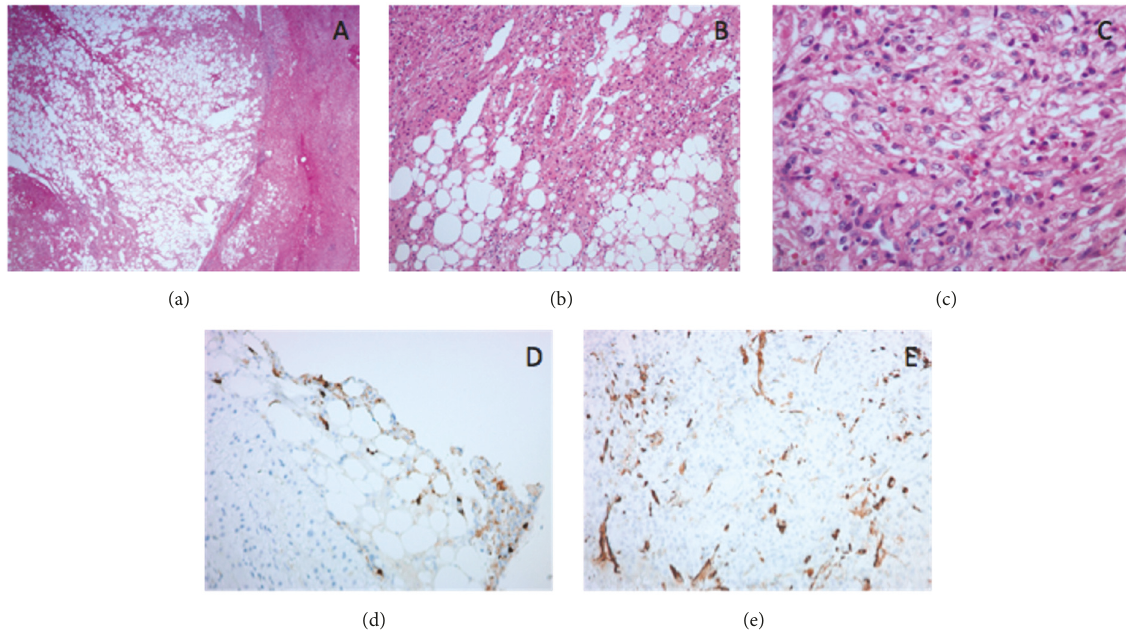
Figure3: Histopathologicfeaturesofepithelioidangiomyolipoma .(a)Well-circumscribedmasswithadjacent,mildlysteatoticliverparenchyma (H&E; 20x). (b) The tumor is composed of eosinophilic cells, mature adipocytes, and thick walled vessels (center) (H&E; 100x). (c) The smooth muscle component includes a mixture of large epithelioid cells with abundant eosinophilic cytoplasm and prominent nucleoli, with interspersedsmallerepithelioidcellsandspindlecells(H&E;400x).ImmunohistochemistryperformedonthebiopsyofthislesionforHMB45 (200x) (d) and Smooth Muscle Actin (200x) (e) showed patchy, strong positivity in the lesional